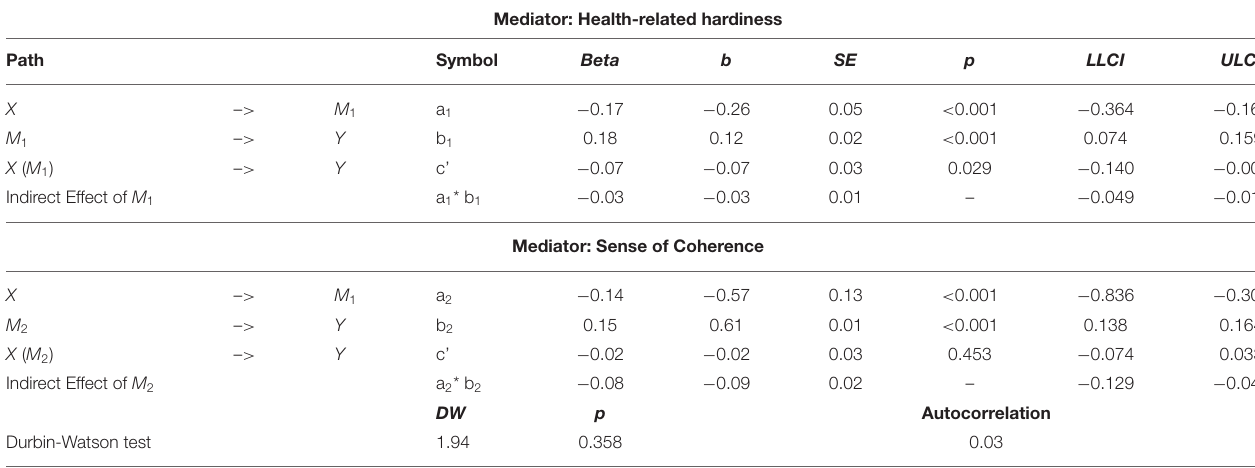
TABLE 3 | Detailed data of the results of the PROCESS MODEL 4 analysis ( N =